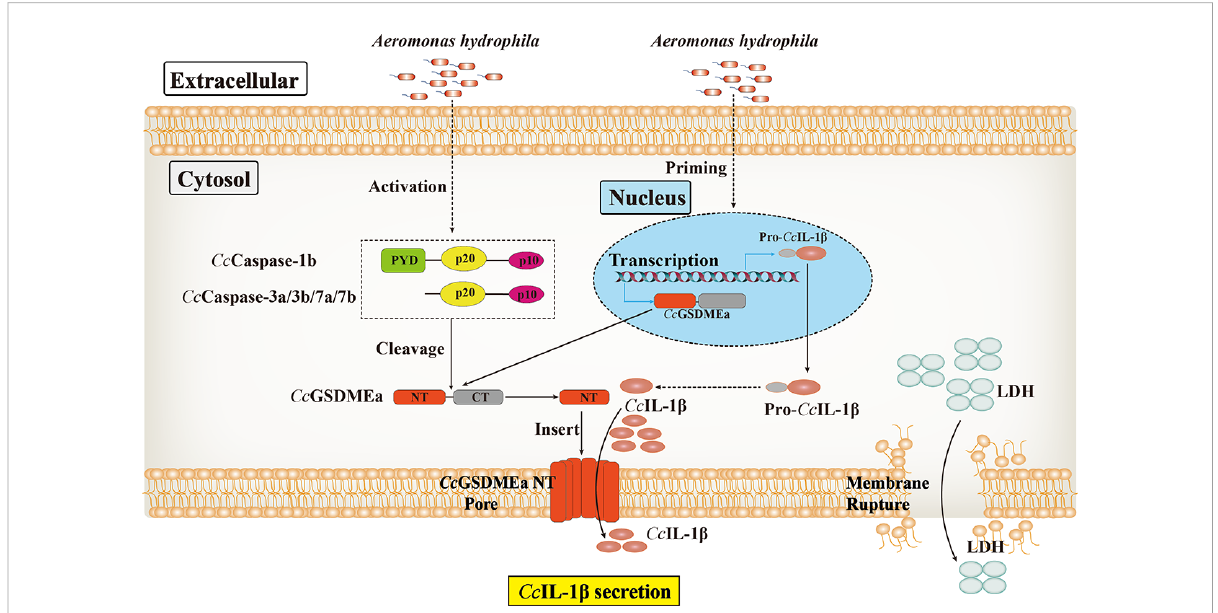
FIGURE 10 The proposed mode of the regulation role of Cc GSDMEa on Cc IL-1 b secretion in common